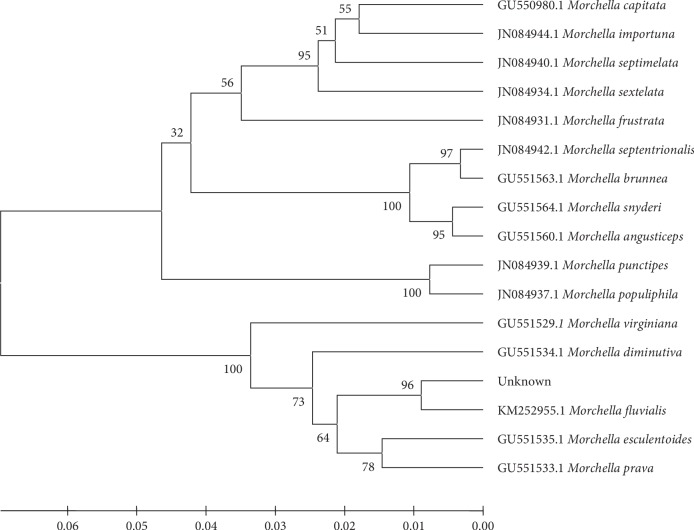
Phylogenetic consensus tree based on EF1-α gene sequences calculated by the UPGMA method. Isolates of Morchella obtained in this study are “unknown.” Numbers on nodes indicate bootstraps (n = 1000).